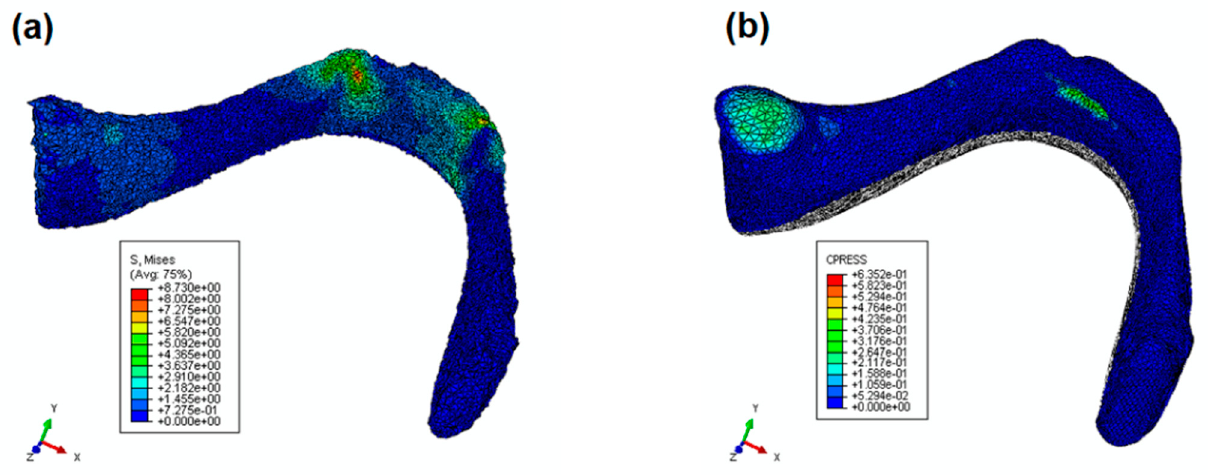
Figure 8. Huber–Mises stress ( a ) and contact stress distribution ( b ) on the cortical bone and gingiva, respectively (contour plots for the canine load case and matrix of 3rd level of retention).